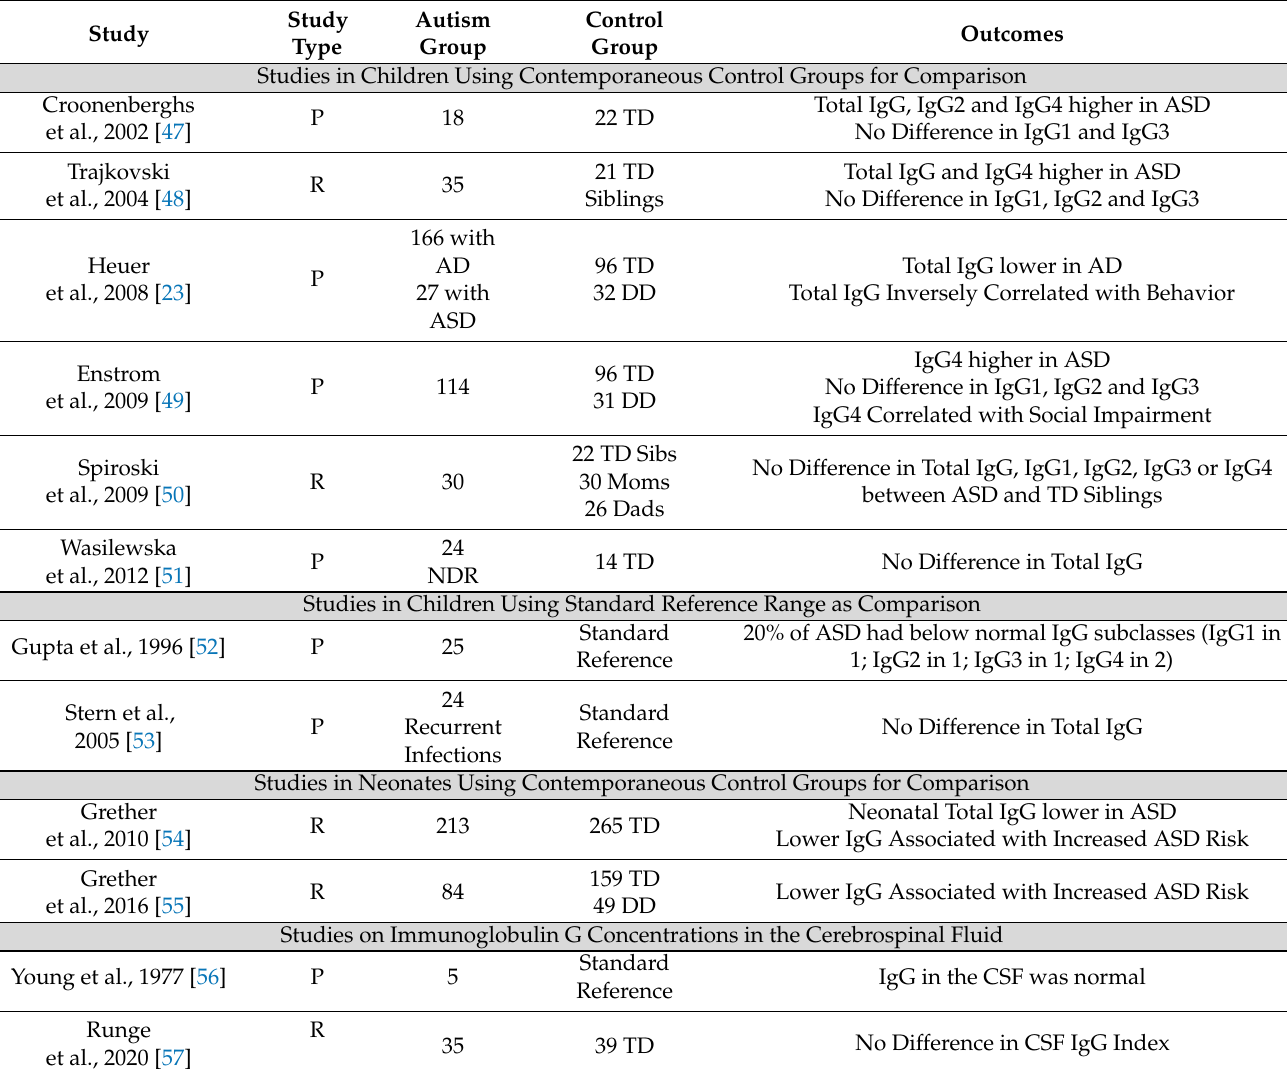
Table 1. Studies of Immunoglobulin G Concentration in Autism Spectrum Disorder. DD = Developmental Delay, TD = Typical Developing, P = Prospective, R = Retrospective; CSF = Cerebrospinal Fluid; AD = Autistic Disorder; NDR = Neurodevelopmental